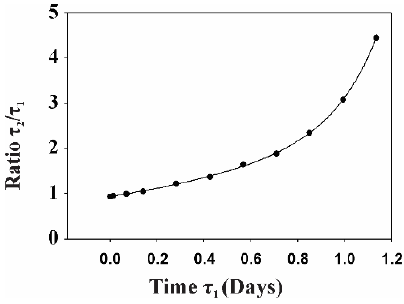
Figure 3. The dependence of τ 2 / τ 1 on τ 1 , where t 0 is constant and equal to 10